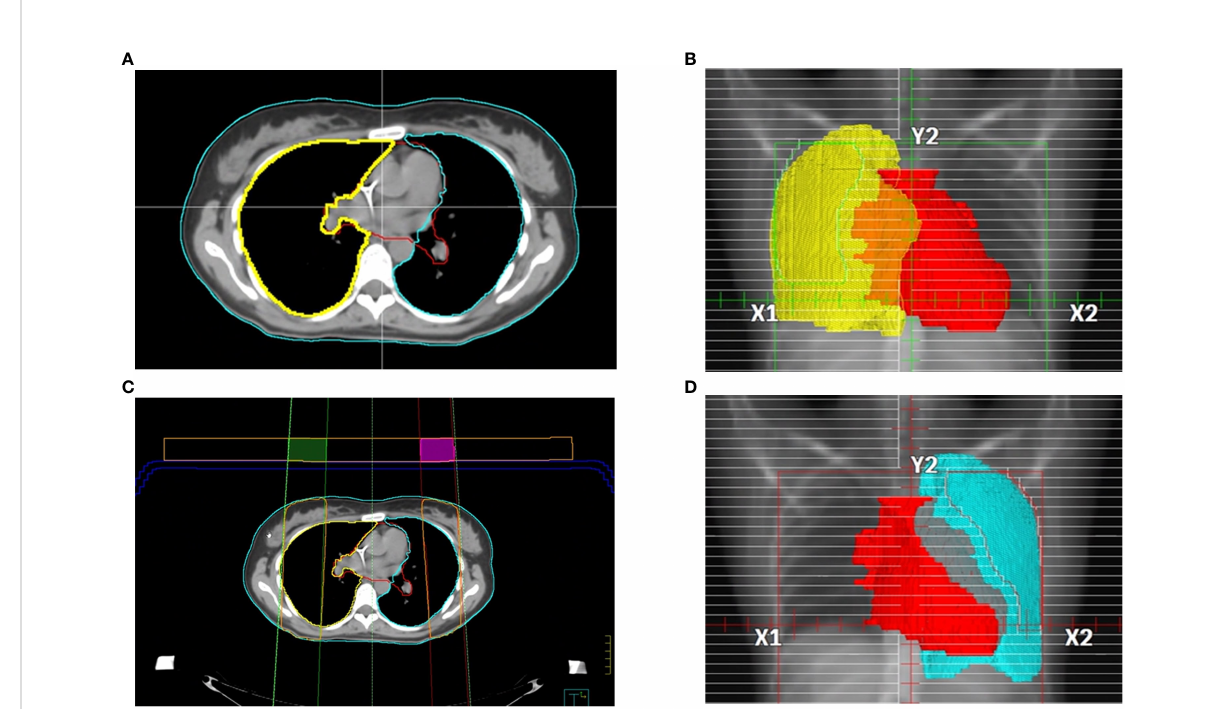
FIGURE 2 Main steps of lung blocks design: (A) example of axial CT images with several representative contours, in details described in the manuscript. Pinnacle BEV window for (B) right and (D) left lung block design. (C) block tray (in blue) and 3 cm thickness parallelepiped ROI with the right and left block beams, 60% isodose line (in orange). The intersection of the of contours generated by the 60% isodose line and the 3 cm thickness parallelepiped ROI produced the right (green) and left (purple) lung blocks to be